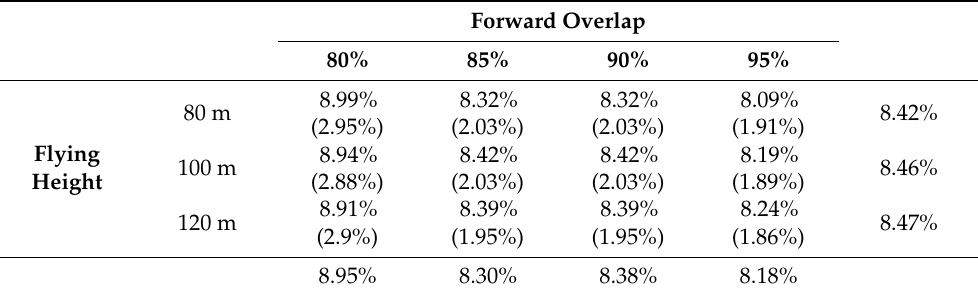
Table 6. RMSE TCH across the levels of flying height and forward overlap in relative (%) values. Values are the mean and standard deviation (in parentheses) for the four sites. Marginal values are row and column averages.